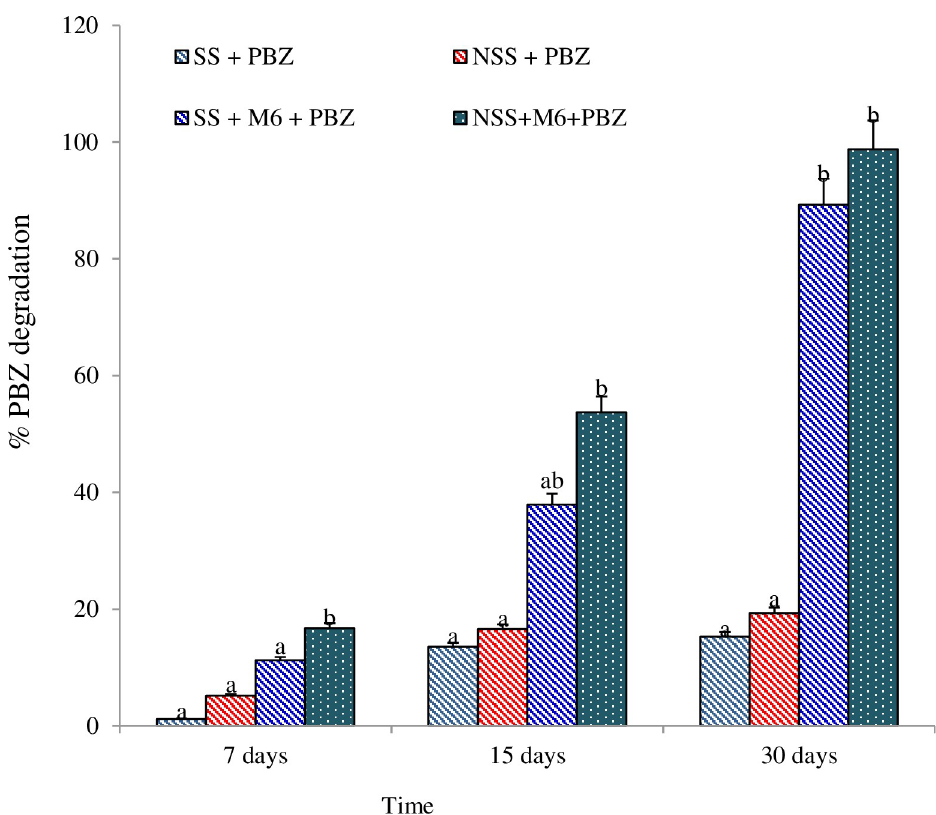
Fig 6. PBZ degradation in sterile and non-sterile soils with strain M6 in three different sampling.